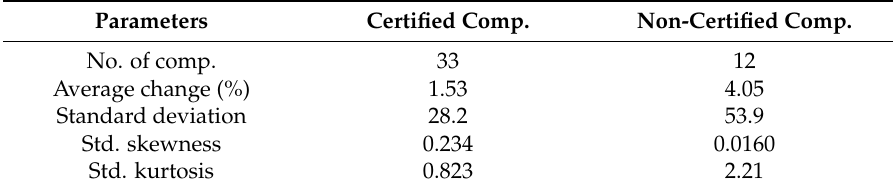
Table 3. Summary statistics on the change in electricity efficiency improvement in the period 1997–2003. Std.: